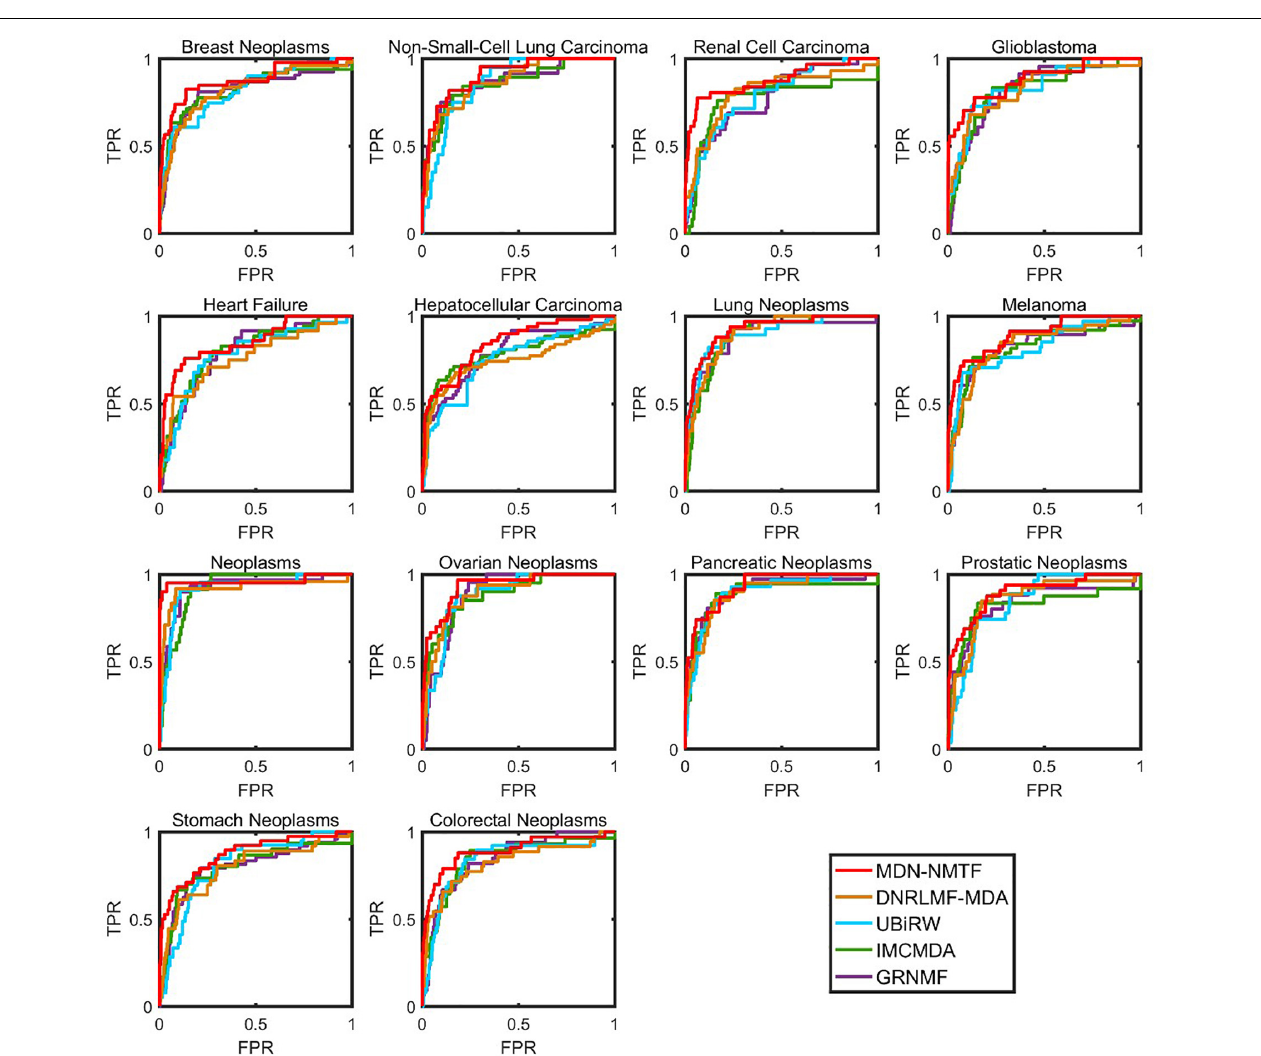
FIGURE 2 | The ROC curves of MDN-NMTF and other four methods for 14 diseases on HMDD2.0-Yan Dataset. The figure shows that the ROC curves of MDN-NMTF in 14 diseases are all higher than that of the other four methods.